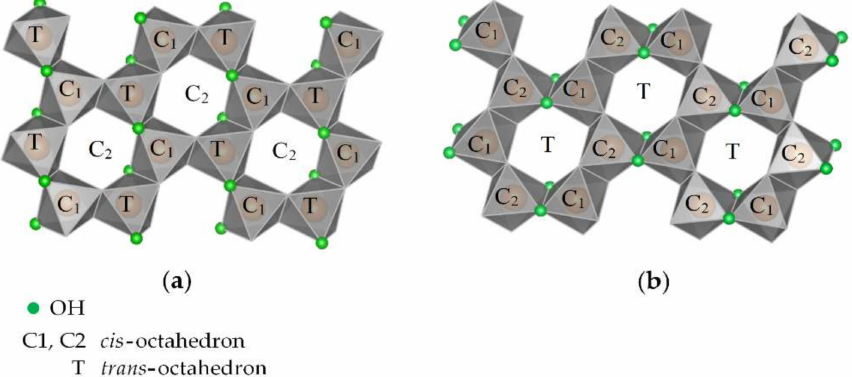
Figure 3. Octahedral sheet of ( a ) cis -vacant configuration and ( b ) trans -vacant configuration in dioctahedral